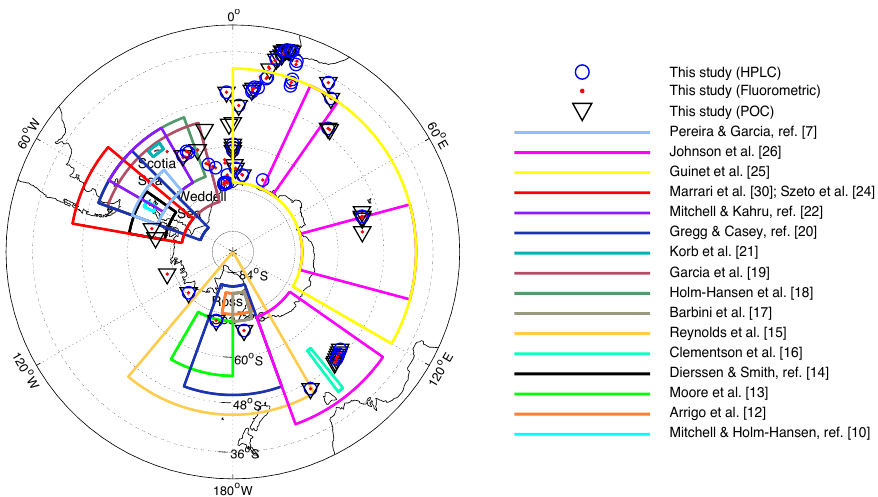
Figure 2. Localizations of matchups from this study and several research areas of previous matchup studies evaluating chlorophyll-a satellite products. The blue circles, red dots and black triangles correspond to matchups from this study for chlorophyll-a measured by HPLC, fluorometry, and POC